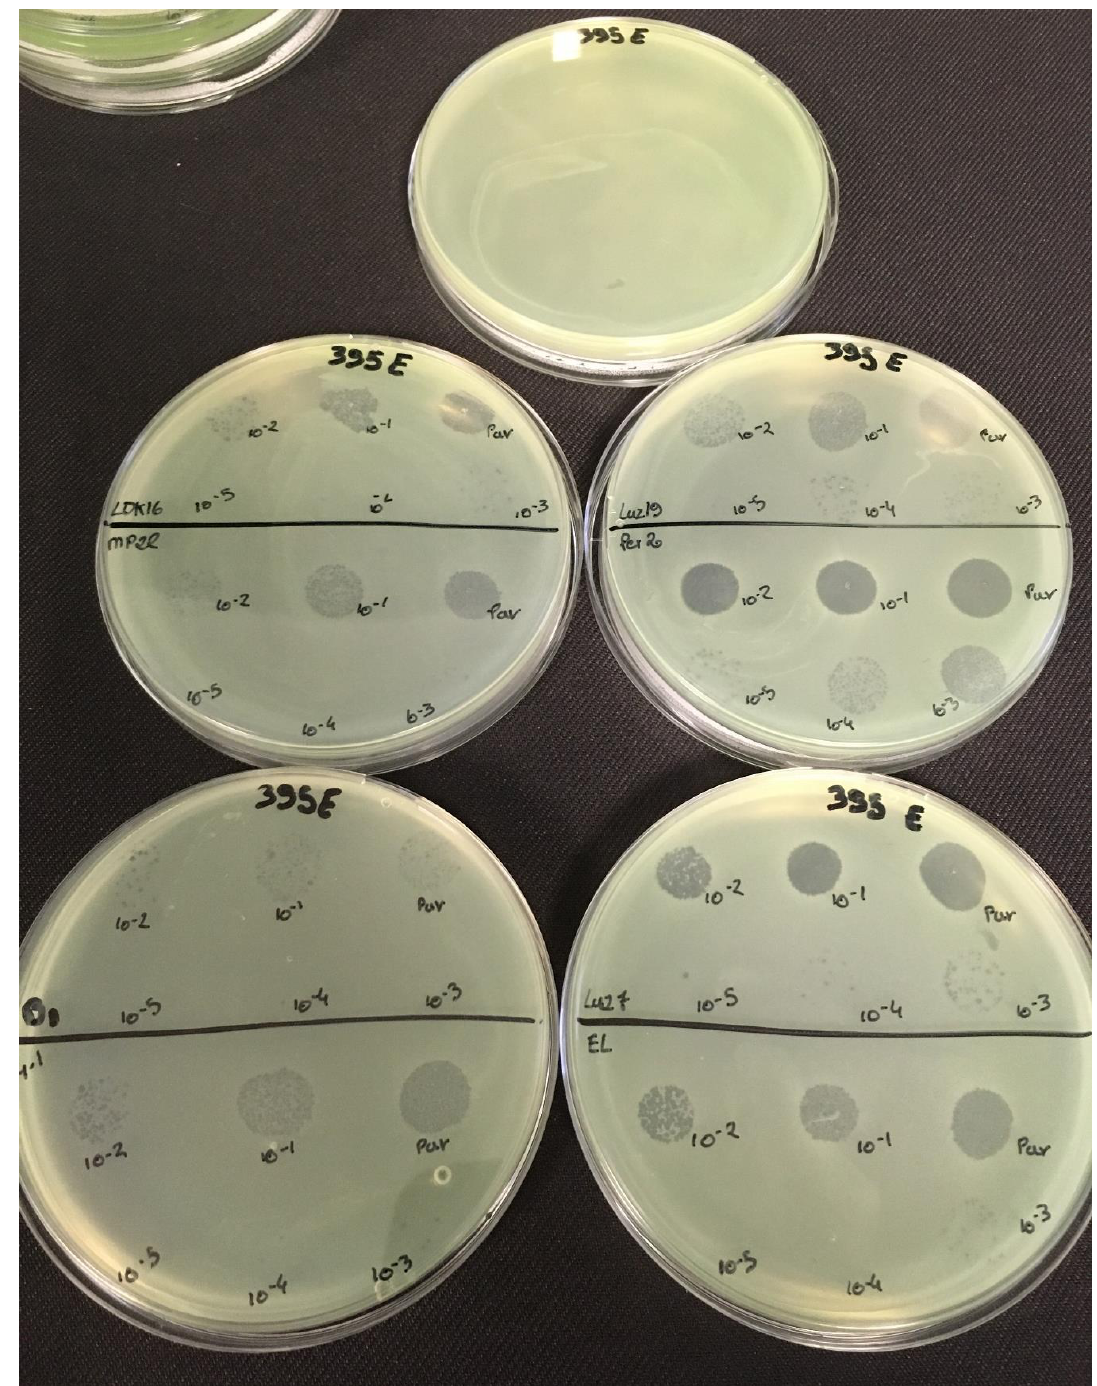
Figure A4. Plaque lysis forming from one spot test assay on the ST395E isolate with diluted phage suspensions. Each plate corresponds to the plaque lysis from two tested phages. The first plate at the top of the picture corresponds to the growth control of the isolate without phages.